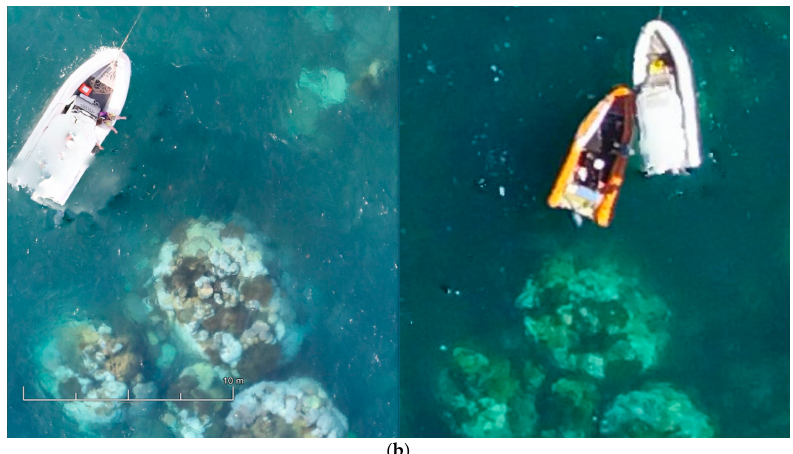
Figure 15. ( a ) Photogrammetry orthomosaic of western part of Pandora Reef (8 Ha) shows 400% zoomed fragments of bleaching events and the AIMS’s Antares research boat on the bottom right (tide height 1.6 m). ( b ) Fragments of the orthomosaics from Canon 5DS R (left) and DJI Phantom 3 Pro imagery (right).